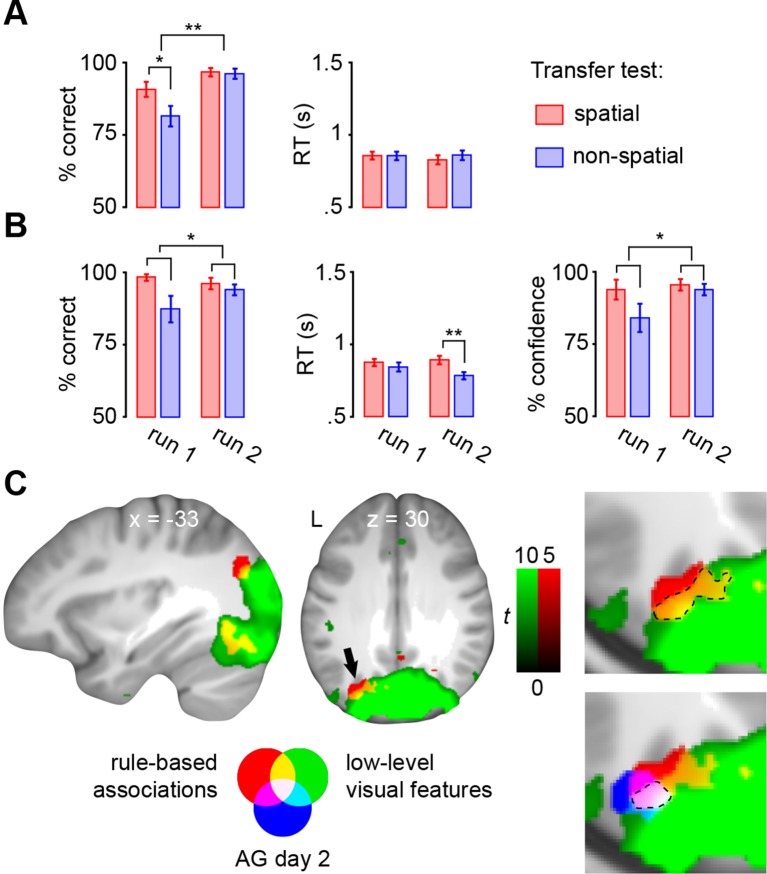
Transfer test.(A) Schema encoding: left, % of correct responses; right, average reaction time (s). (B) Schema retrieval: left, % of correct responses; middle, average reaction time (s); right, % of high-confident ratings (i.e. “sure”-responses). Error bars denote ± s.e.m. * marks significance at P < 0.05, ** marks significance at P < 0.001. (C) Multi-voxel patterns of rule-based associations and low-level visual features were shared between day 2 and the transfer test. Magnified cut-outs of the horizontal slice are provided to appreciate the overlap between schema components. The AG cluster showing schema convergence during day 2 is depicted in blue (Figure 5A). For display purposes, all maps were resliced to a voxel dimension of 0.5 mm isotropic and are shown at P < 0.001, uncorrected. Significant clusters are noted in Table 5. L – left.